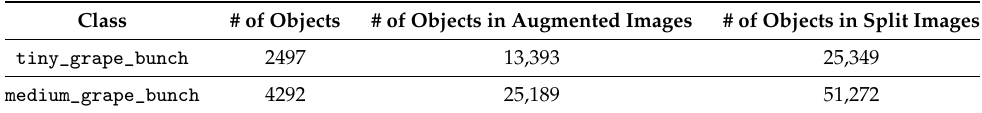
Figure 4. Set of augmentation operations applied to a single image to extend the original dataset. Table 3 contains the information about the number of annotated objects per class in the three different stages of the dataset: original images, augmented images, and split images. Table 3. Number of annotated objects per class. The original dataset contains 1929 images with two different classes. To increase the dataset size, several augmentation operations were applied, increasing the number of images to 13,503. Finally, the images were split, and the final dataset was composed of 302,252